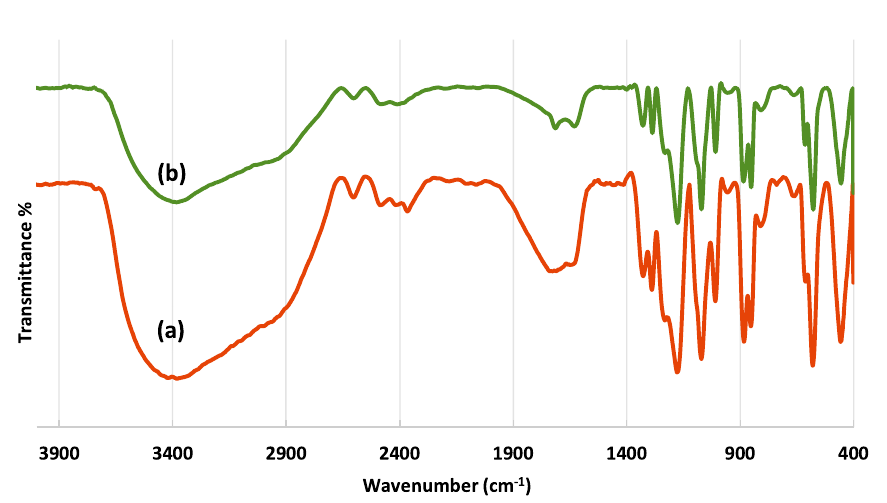
Figure 7. The FT-IR spectra of the fresh MCM-41-SO 3 H ( a ), and the recovered one ( b